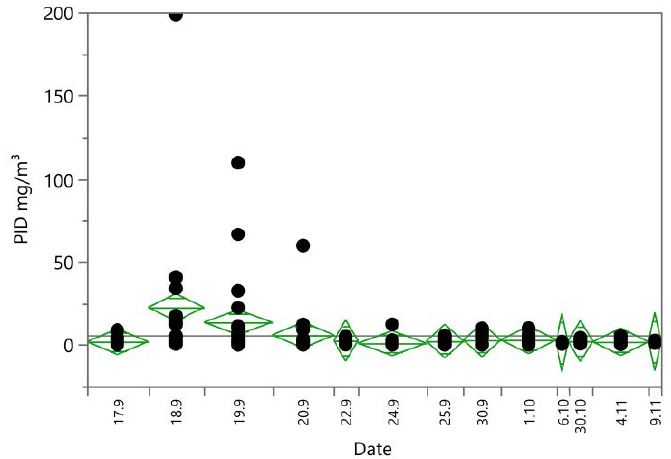
Figure 5. Analysis of variability CO 2 with the influence of the depth. Table 5. Result of Kruskal–Wallis tests—analysis of CO 2 variability with the influence of the date.